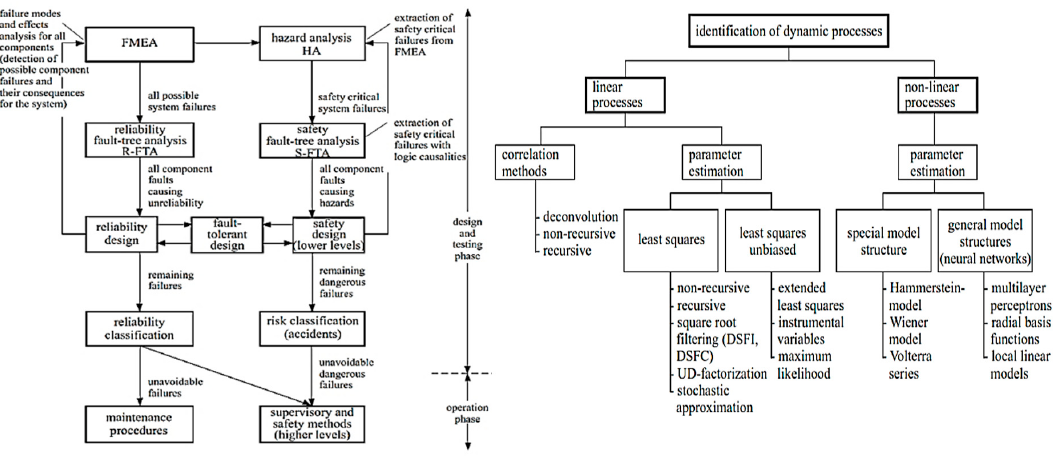
Figure 3. Framework integrating reliability and safety levels [43,44].